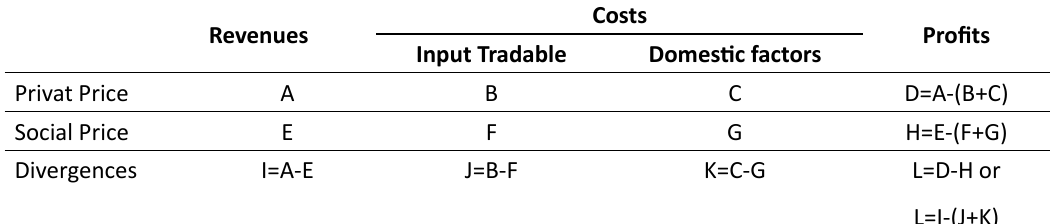
Table 1: The Structure of Policy Analysis Matrix Revenues